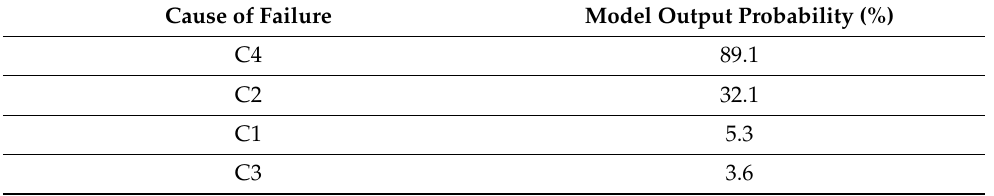
Table 2. Validity validation results.